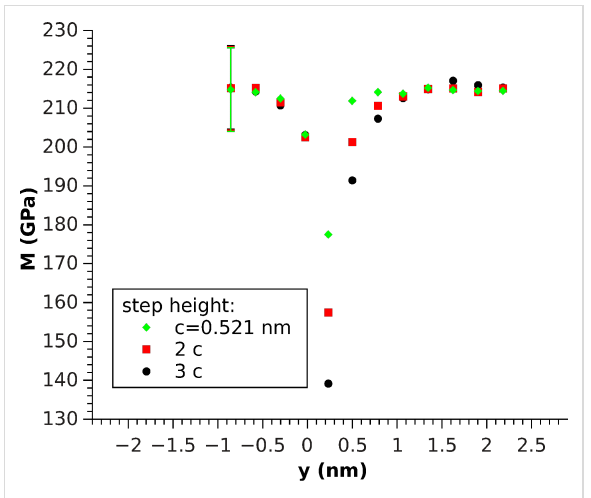
Figure 3: Local [001]-oriented indentation modulus for three different step heights along the y -axis. Measured by indenting a single atom ( A 1 = 0.088 nm 2 ). The error bars denote the standard deviation of the displacement and apply to all data points.